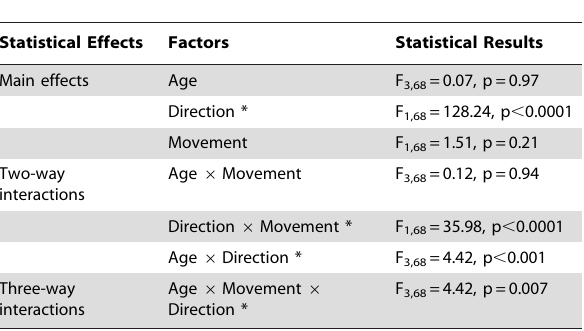
Table 1. Main and interaction effects of the ANOVA analysis.